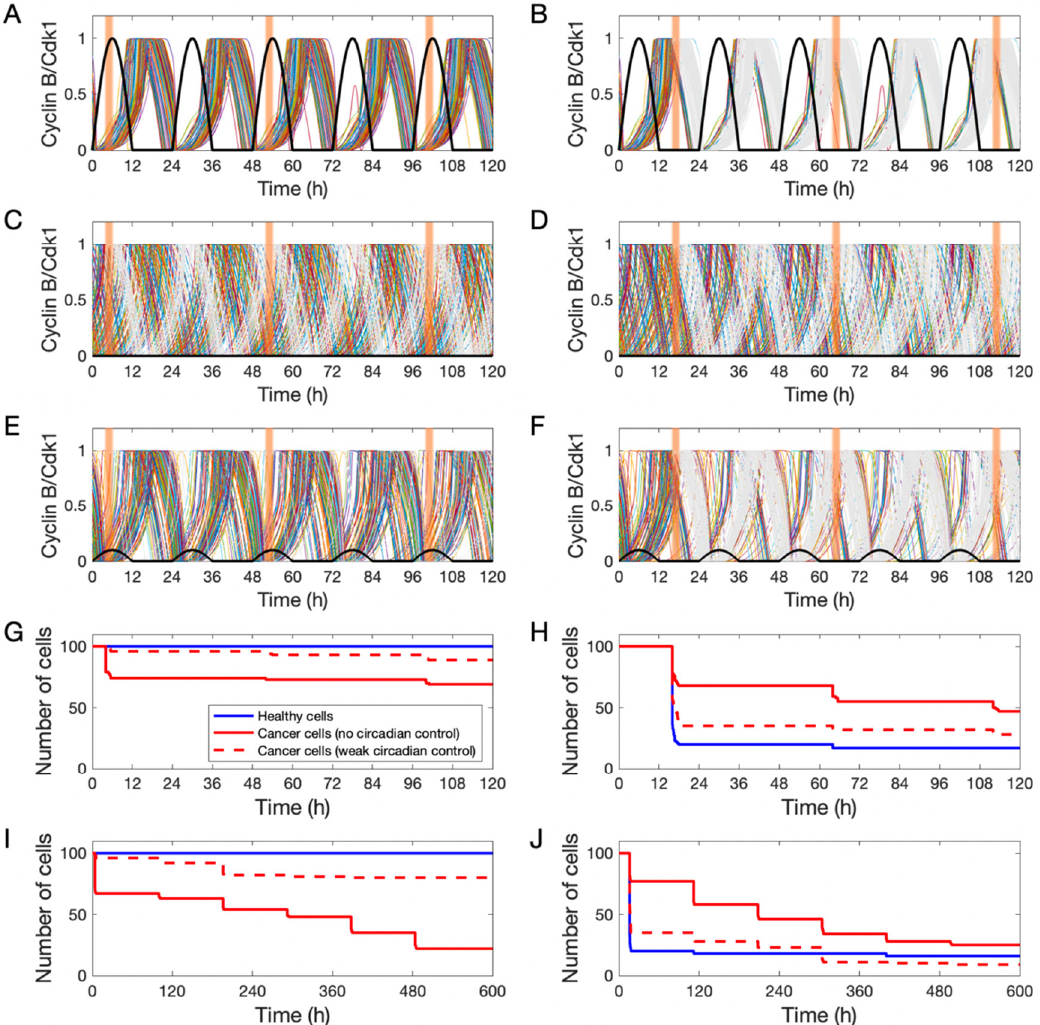
Figure 4. Effect of an anti-cancer drug administrated at different times. Effect of anti-mitotic drug given at ZT 4 (left panels) and at ZT 16 (right panels) on entrained (healthy) cells (panels ( A , B ), A = 1) and on non-entrained (panels ( C , D ), A = 0) or weakly entrained cells (panels ( E , F ), A = 0.1). ( G , J ) Evolution of the number of (living) cells over time. In these simulations, the initial number of cells was 100, the drug targets cells with a level of cyclin B/Cdk1 ( Mb ) larger than 0.95 (i.e., cells in M phase), the duration of the application of the drug was 2 h and the drug is delivered every 2 days (panels ( A – H )) or every 4 days over a longer period of time (panels ( I , J )). ZT 0 corresponds to the beginning of the L phase (i.e., start of expression of Wee1 ). The black curves in panels ( A – F ) denote the profile of Wee1 activity. The orange bars indicate the time and duration of the application of the drug. In panels ( A – F ), the color curves are the levels of Mb in living cells, while the grey curves indicate the (virtual) profile of Mb in dead cells, i.e., the profile of Mb is the cells that have been targeted (and thereby killed) by the anti-mitotic drug. The fraction of living cells is number of cells that were not exposed to the drug while having a high level of Cyclin B/Cdk1, divided by the initial number of cells (100 in the present case).